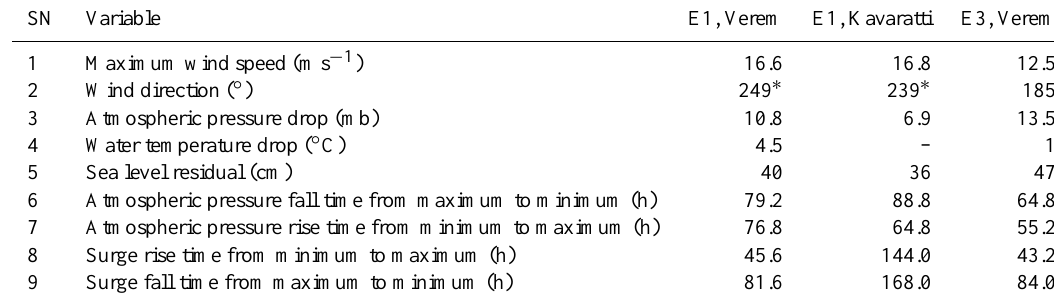
Table 2. Meteorological and sea level observations at Verem and